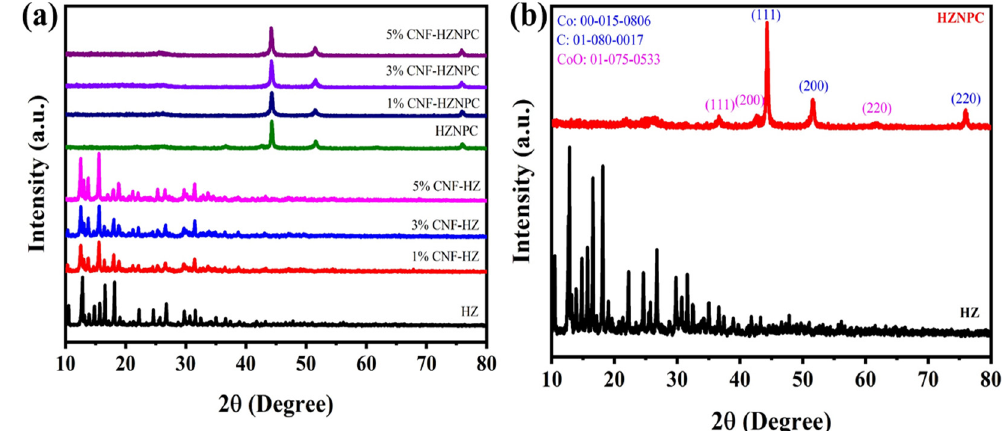
Figure 2. XRD patterns of ( a ) all samples( b ) HZ and HZNPC.